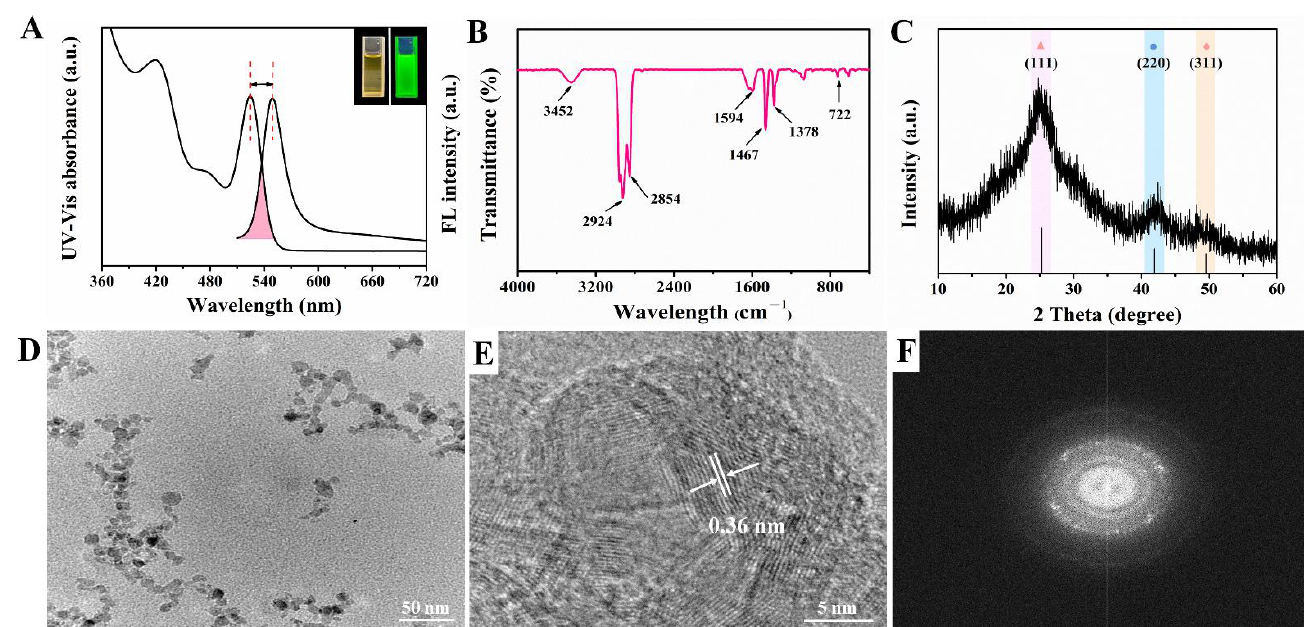
Figure 2. Characterization of oil-soluble CdSe QDs ( A ) Fluorescence spectrum and UV-vis absorption spectrum; the upper right inset showed the photos taken under sunlight and ultraviolet light separately. ( B ) FT-IR spectrum. ( C ) XRD pattern. ( D ) TEM image. ( E ) HR-TEM image. ( F ) SADE pattern.